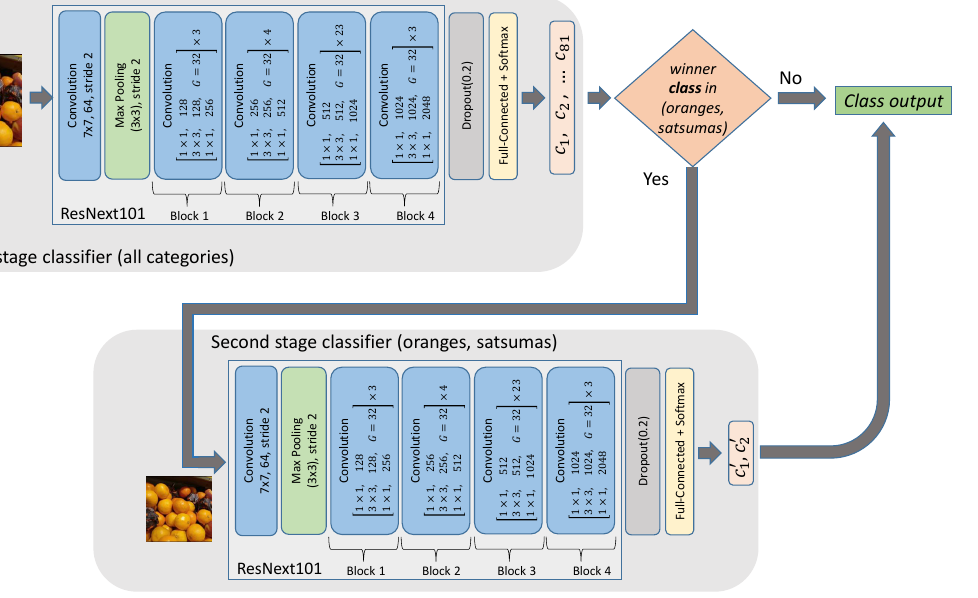
Figure 1. Cascade classifier based on